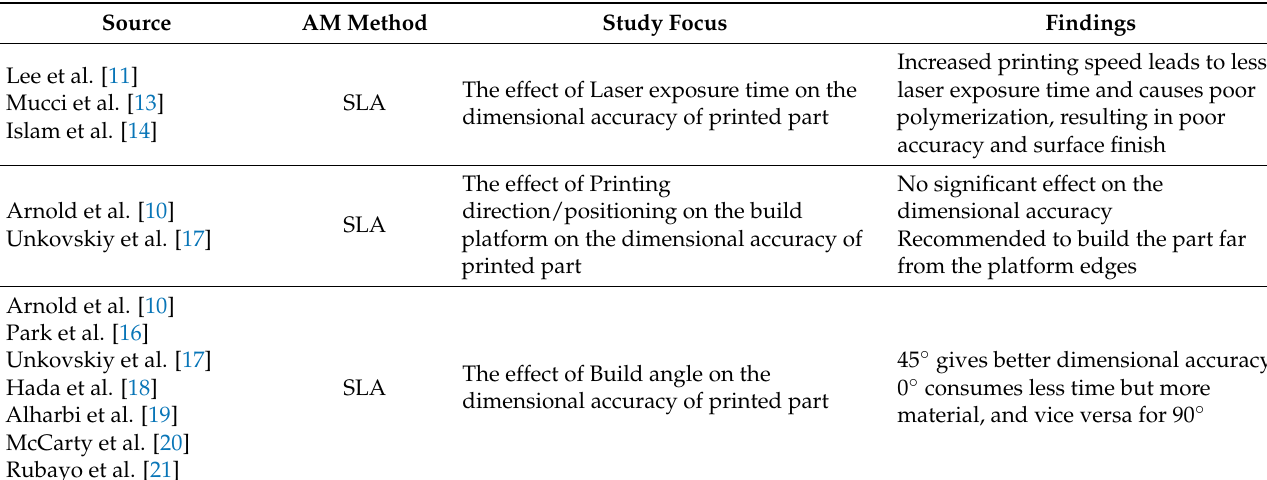
Table 1. Summary of literature